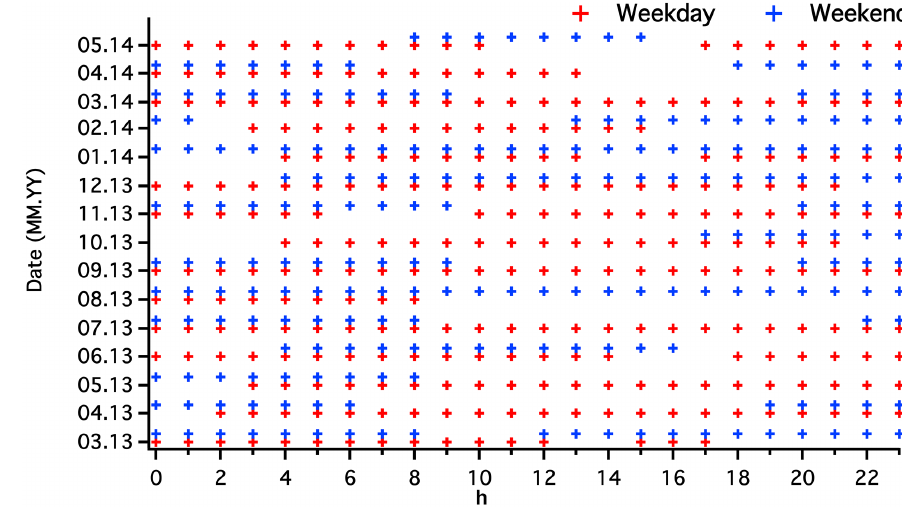
Figure 4. Days (weekdays in red crosses and weekends in blue crosses) and hour sampled per month with our